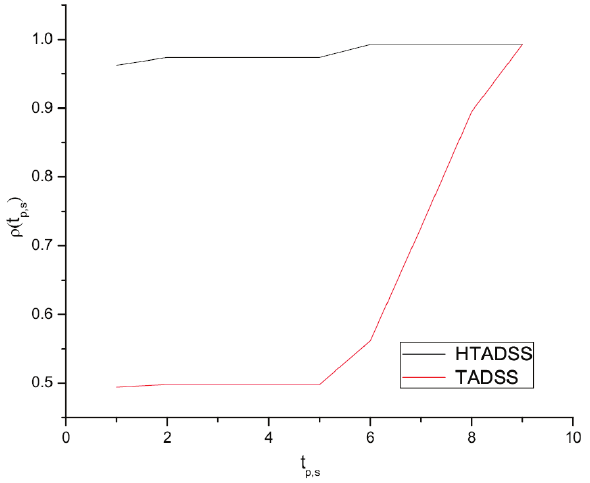
Figure 7. Performance profiles for the HTADSS and TADSS methods regarding the number of iterations metrics.